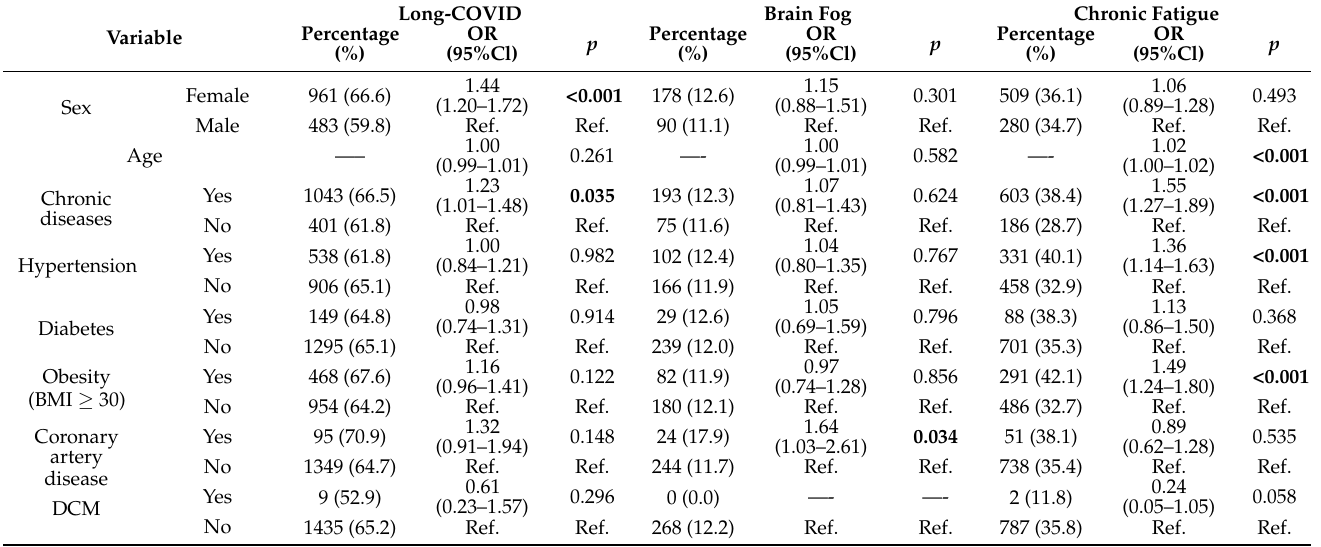
Figure 1. Univariate analysis of risk factors for developing long-COVID syndrome, chronic fatigue, and brain fog. Table 3. Univariate analysis determining the effect of sociodemographic variables, chronic conditions, influenza and COVID-19 vaccination status, and COVID-19 course on the risk of developing long- COVID syndrome, as well as brain fog symptoms and chronic